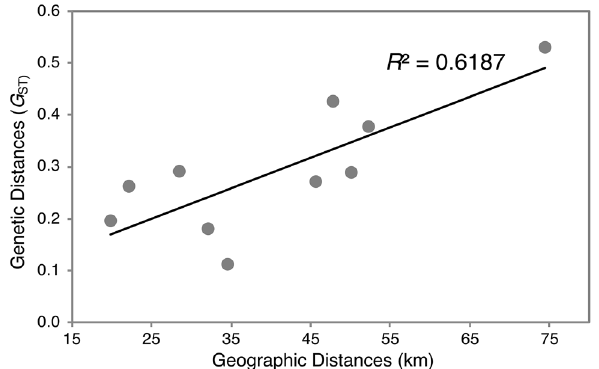
Figure 2. A plot showing that the genetic distance ( G ST ) is determined by the spatial distance (along the water way) between the five Han River populations of Rhodeus pseudosericeus .